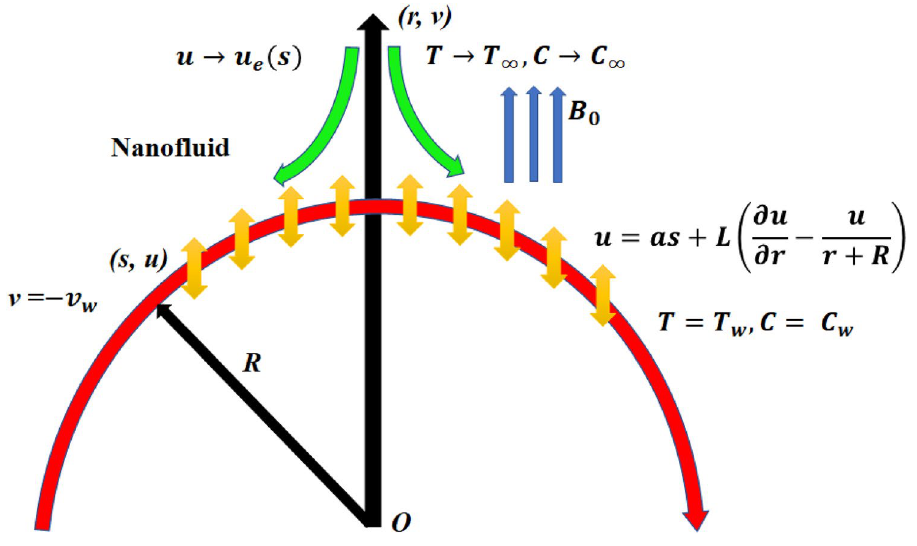
Figure 1. Schematic